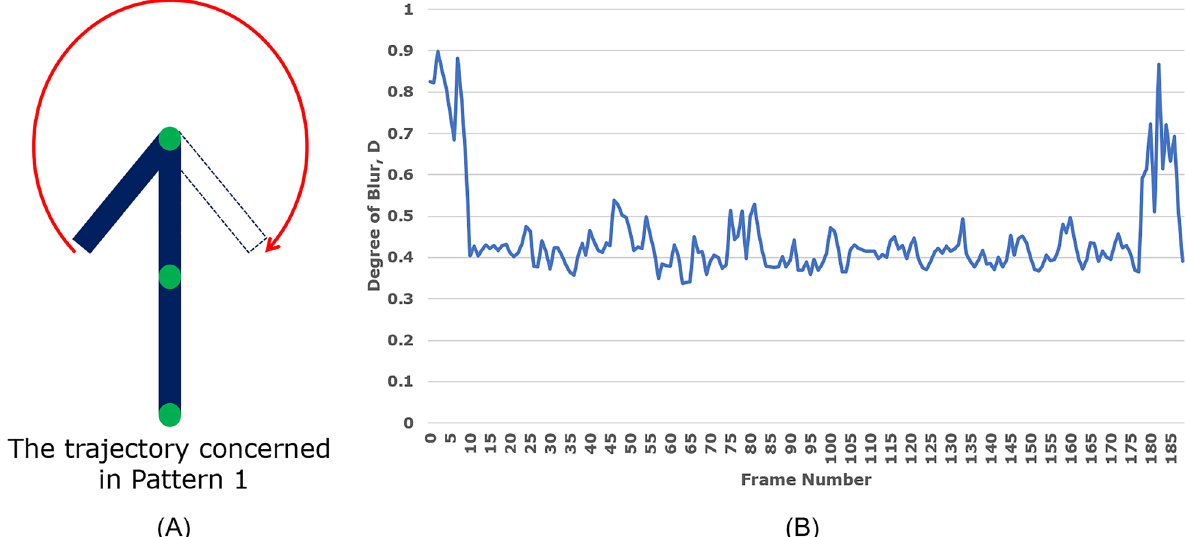
Fig. 6 The degree of blur evaluation result of Pattern 1. A The trajectory of Pattern 1. B The tendency of blurry degree D according to the frame